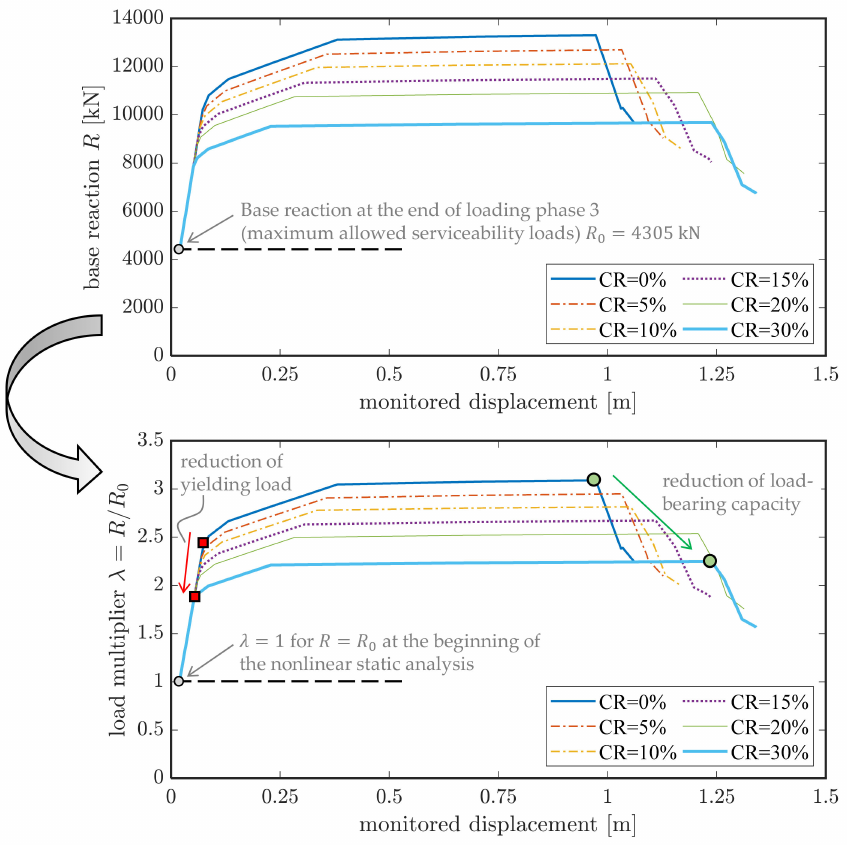
Figure 20. Results from nonlinear static analysis of the bridge deck: pushover curve ( top ) and corresponding load multiplier λ computed by normalizing the base reaction with respect to the value obtained at the end of loading phase 3 ( bottom